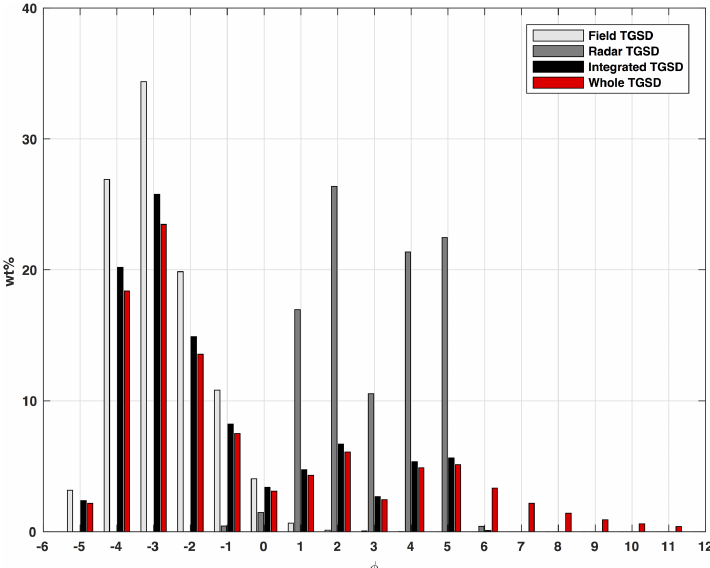
Figure 5. Input TGSDs estimated from either field or X-Radar data. The Integrated TGSD emerges from a weighting average combination of the Field and Radar TGSDs. The Whole TGSD derives from the Integrated TGSD modified to implement the satellite